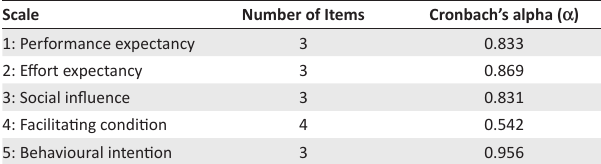
TABLE 2: Empirical reliability of data collection instrument.